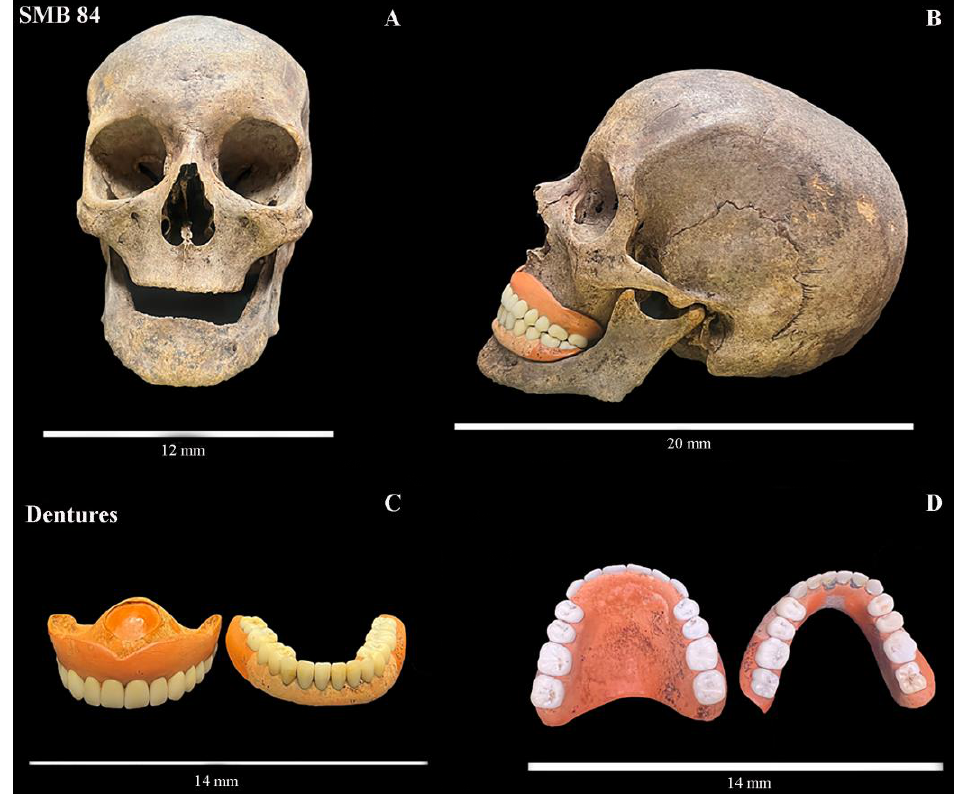
Figure 1. SMB 84 — adult female (age range 50 – 59 years.). Vulcanite base dentures with porcelain teeth. Images show dentures in situ and removed from the maxilla and mandible. ( A ) . Anterior view of the edentulous maxilla and mandible. ( B ) . Left lateral view of the ‘well - made’ dentures with a class one occlusion in the jaw. ( C , D ) . The vulcanite dentures with porcelain teeth — the maxillary denture shows a shield shape suction area on the superior surface of the plate. © Angela Gurr.